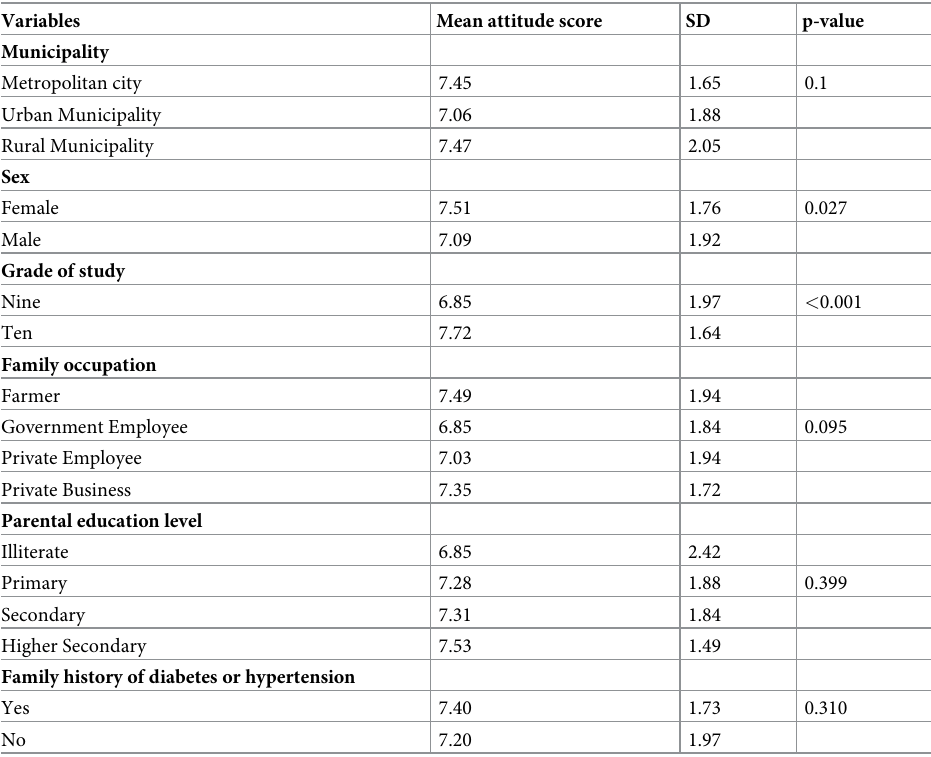
Table 5. Respondents’ attitude scores on diabetes and hypertension by socio-demographic characteristics.